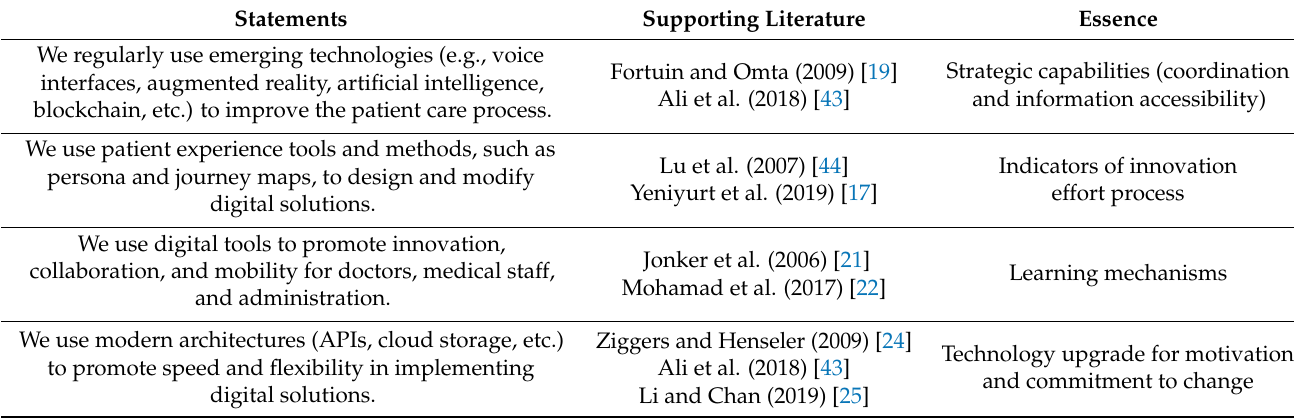
Table 1. Statements used to assess TC with supporting literature.